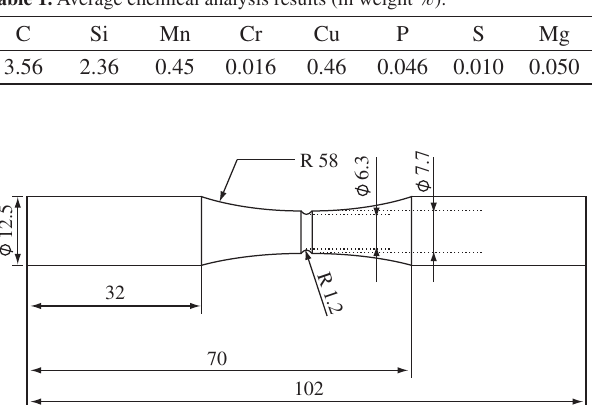
Figure 3. Notched testpiece for bending rotating fatigue tests.